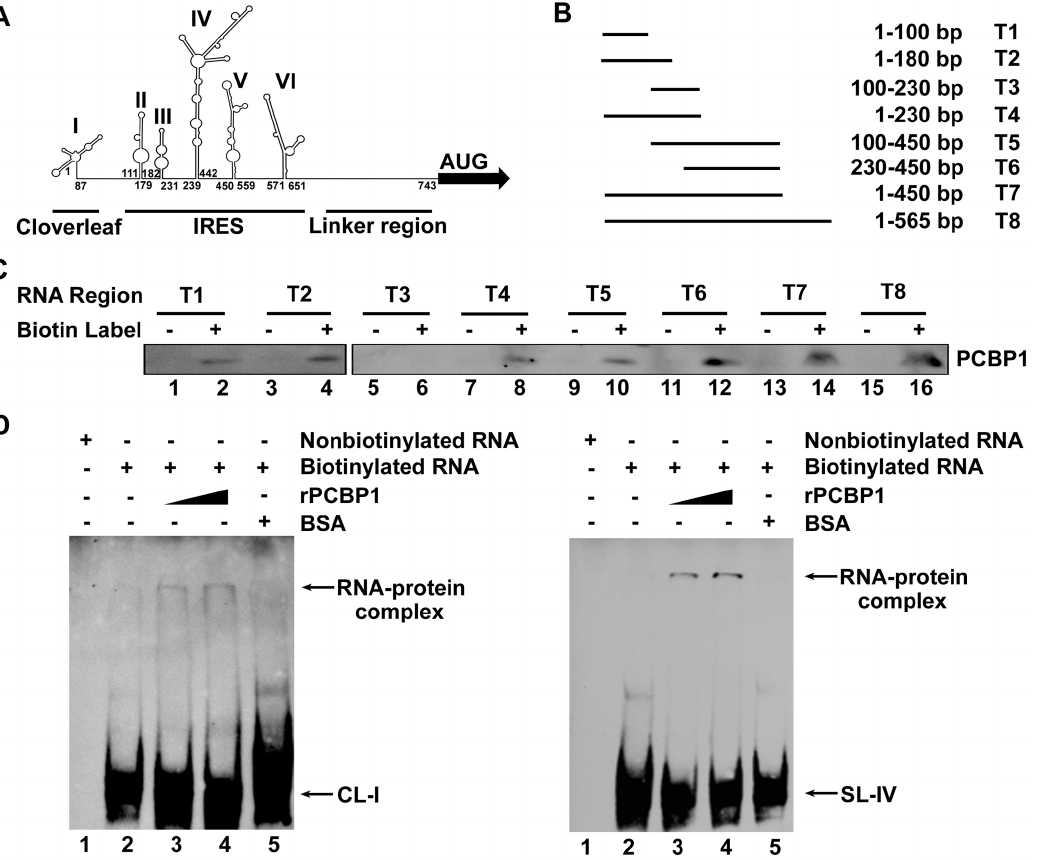
Figure 2. Determination of the sequences in 5 9 UTR of EV71 RNA required for the binding of PCBP1. (A) The secondary structure of the full-length 5 9 UTR of EV71 RNA was predicted using the M-FOLD software (http://mfold.rna.albany.edu). In this predicted secondary structure, six domains (or stem-loops) were shown with first and last nucleotides numbered: domain I (nt 1 to 87), II (nt 111 to 179), III (nt 182 to 231), IV (nt 239 to 442), V (nt 450 to 559), and VI (nt 571 to 651). The three functional regions, cloverleaf, IRES, and linker, were underlined based on previous report [11]. (B) A series of plasmids carrying different deletions in the six stem-loops of EV71 5 9 UTR were generated: pcDNA3.0-5 9 UTR (T1, 1–100), (T2, 1–180), (T3, 100–230), (T4, 1–230), (T5, 100–450), (T6, 230–450), (T7, 1–450), and (T8, 1–565). (C) The plasmids were linearized and transcribed into RNA in vitro , which were then labeled with biotin-16-UTP. For the pull-down assay, cell extracts were mixed with these biotinylated EV71 5 9 UTR RNAs or nonbiotinylated RNAs as control (lanes 1, 3, 5, 7, 9, 11, 13, and 15). The complex was dissolved and PCBP1 protein was determined by western blot using a mouse anti-PCBP1 antibody (lanes 2, 4, 6, 8, 10, 12, 14, and 16). (D) EMSA assay for domain I (CL-I) and IV (SL-IV). Labeled RNA (CL-1 or SL-IV) (0.5 m g) was incubated with rPCBP1 at 0, 0.1, and 0.2 m g (lanes 2 to 4) or BSA at 0.2 m g (lane 5), respectively. No-labeled RNA was used as a control (lane 1). The RNA-protein complex was separated from free probe RNA and examined by an EMSA. The bound RNA is indicated by an arrow.